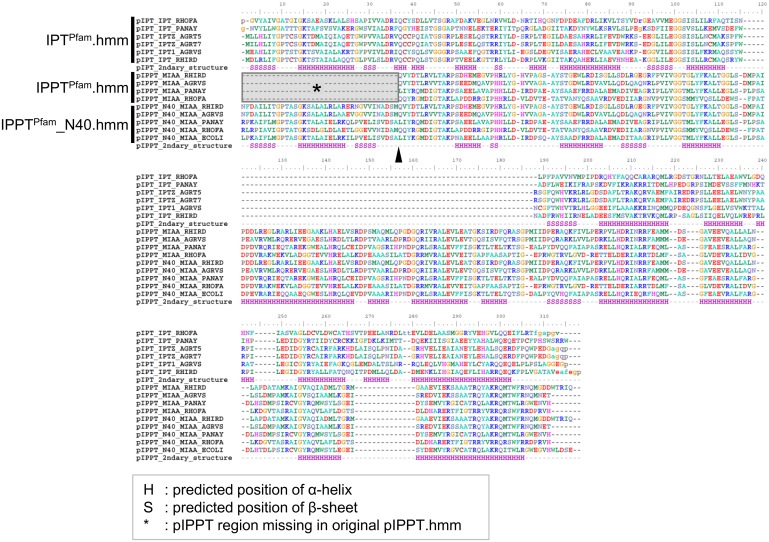
Domain sequences used for HMM profiles.Original IPPTPfam domain sequences were shorter than the IPTPfam domain by approximately 40 AA at the N-terminus. The expanded profile was retrieved from full sequences and used for the new HMM profile (IPPTPfam_N40.hmm). Arrowhead indicates the starting position of the original IPPTPfam.hmm. Box marked with an asterisk indicate the IPPTPfam region missing in the original IPPTPfam.hmm. Predicted positions of α-helixes are indicated by ‘H’, and those of β-sheet by ‘S’.